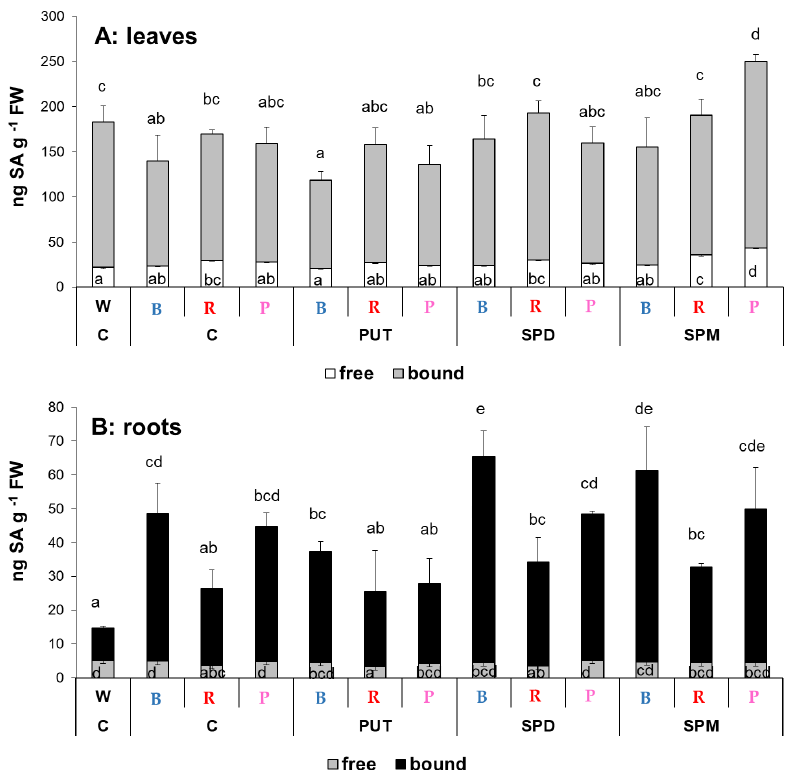
Figure 3. Salicylic acid (SA) contents in the leaves ( A ) and roots ( B ) of plants grown under differ- ent light regimes (white light: W, blue light: B, red + far-red: R and the combination of blue and red + far-red, pink: P) treated with or without polyamines (control: C, putrescine: PUT, spermidine: SPD and spermine: SPM). Values are means ± SD ( n = 3). Different letters indicate statistically significant differences at p < 0.05 level, using Duncan’s post hoc test.